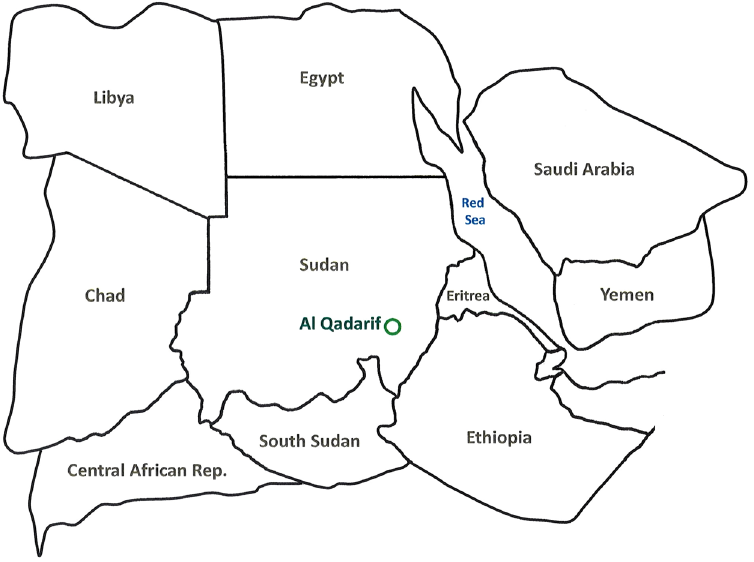
Figure 1. Location of sampling sites: Al Qadarif region, Sudan. The Map marks the city of Al Qadarif, which is the capital of the state Al Qadarif in central Sudan (the map is generated in Microsoft PowerPoint 2016